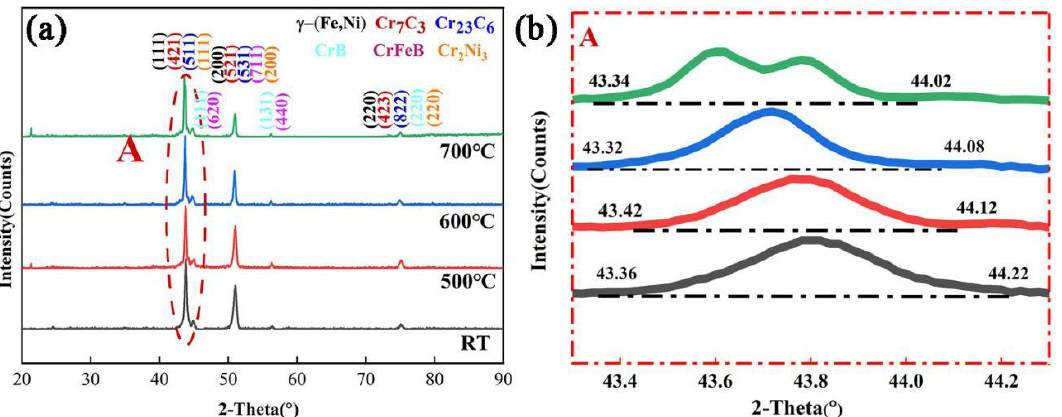
Figure 5. ( a ) XRD patterns of the composite with different thermal treatment temperatures; ( b ) Amplification diagram of the main diffraction peak image of the red highlighted in the section A of Figure 5a.